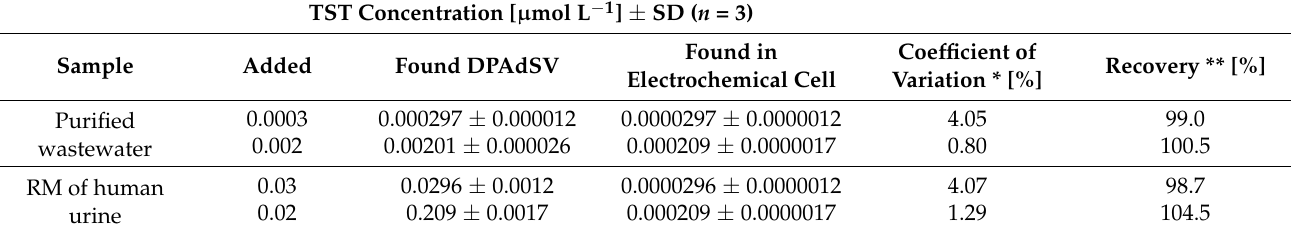
* Coefficient of variation [%] = (SD × 100)/Found DPAdSV, ** Recovery [%] = (Found DPAdSV × 100)/Added.